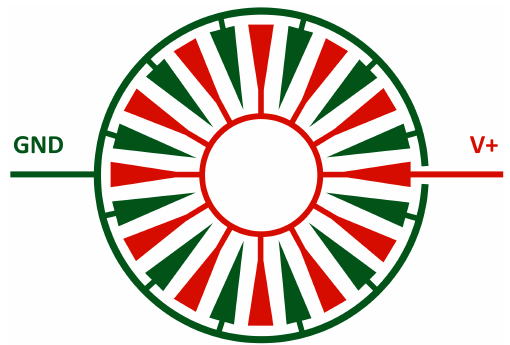
Figure 1. Schematic of areal density modulated electrodes used for electrowetting actuation. The interdigitated electrodes (+V) and counter electrodes (GND) cover an increasing percentage of the available area as the radius from center increases. This ensures that all forces on the oil droplet will be symmetric and that the droplet will be centered over the electrodes as voltage is applied.